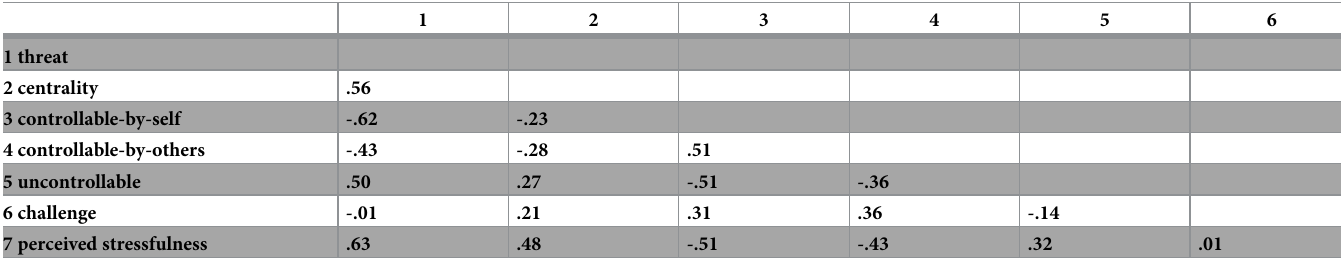
Table 3. Intercorrelations of the SAM